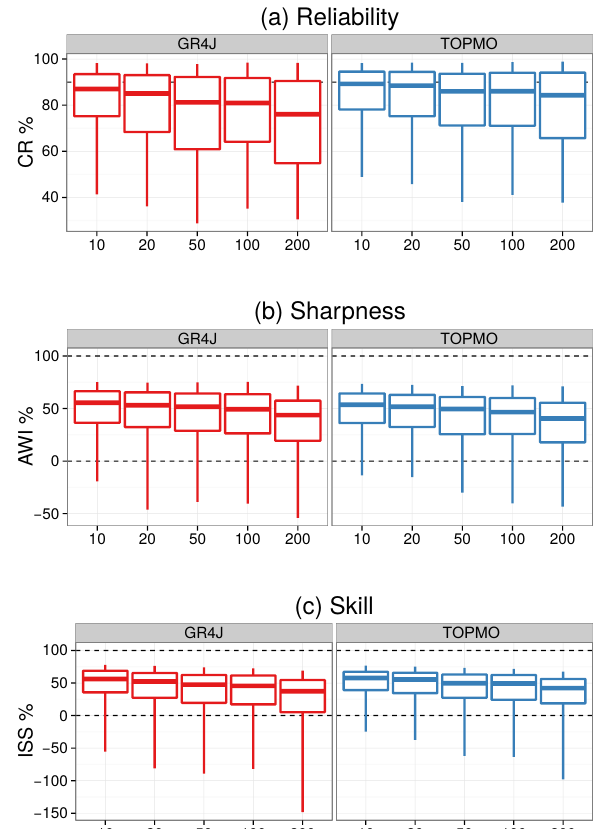
Figure 8. Impact of the hydrometrical desert on the distributions of the three performance criteria. Potential donor catchments are not retained as donors when their distance to the target catchment is below 10, 20, 50, 100 and 200km. Boxplots (5th, 25th, 50th, 75th and 95th percentiles) summarise the variety of scores over the 907 catchments of the data